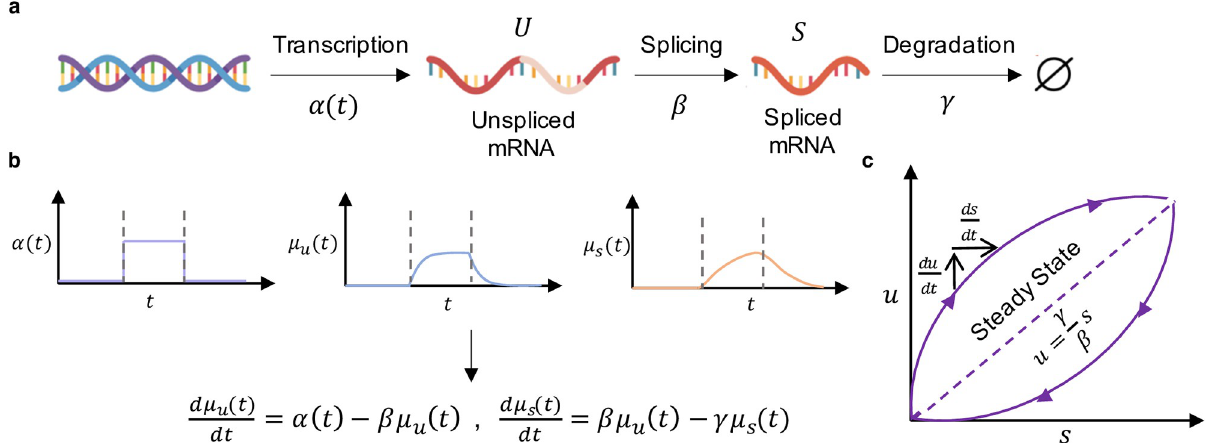
Fig 3. a. The continuous model of transcription, splicing, and degradation used for RNA velocity analysis. b. Plots of α ( t ), μ u ( t ), and μ s ( t ) over time t and the corresponding governing equations for the system. Dashed lines indicate time of switching event. c. Outline of the common phase portrait representation, with both steady state and dynamical models denoted. Adapted from [1]. The DNA and RNA illustrations are derived from the DNA Twemoji by Twitter, Inc., used under CC-BY 4.0.